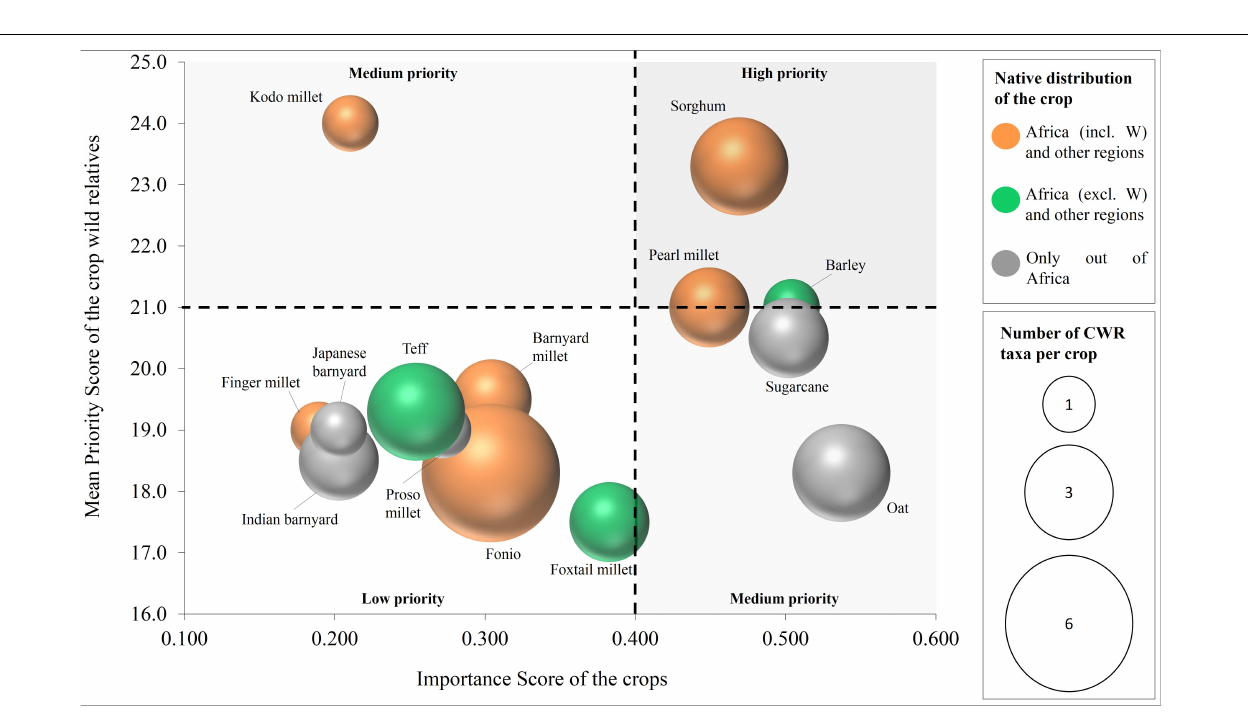
Frontiers in Plant Science |